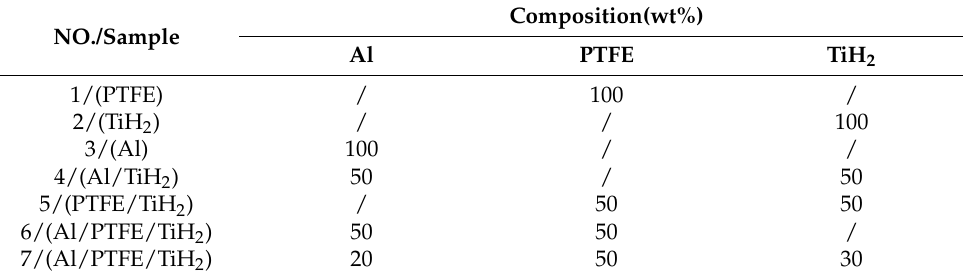
Table 3. Material composition ratio of TG/DSC experiment.